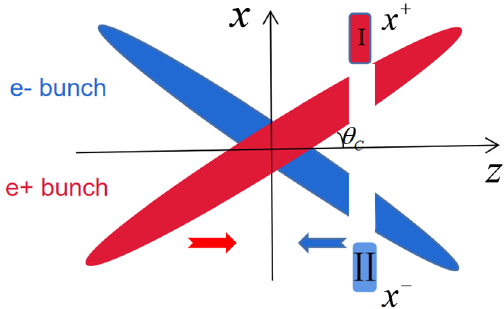
FIG. 5. Beam-beam interaction with a crossing angle in Lorentz boost